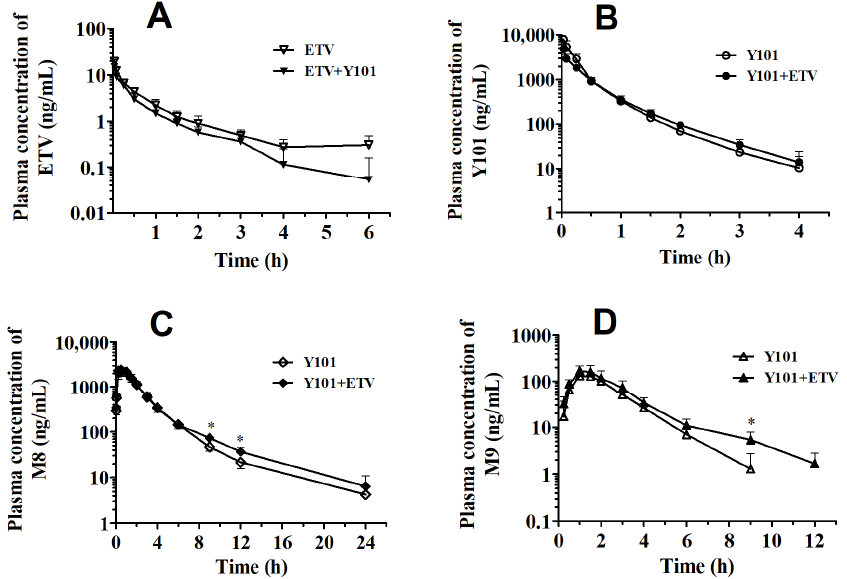
Figure 3. Mean plasma concentration–time curves of ETV ( A ), Y101 ( B ), M8 ( C ) and M9 ( D ) after intravenous administration of Y101 (25 mg/kg) and Y101 + ETV (0.06 mg/kg). Data are expressed as mean ± SD (* p < 0.05 vs. Y101 group; n = 4).